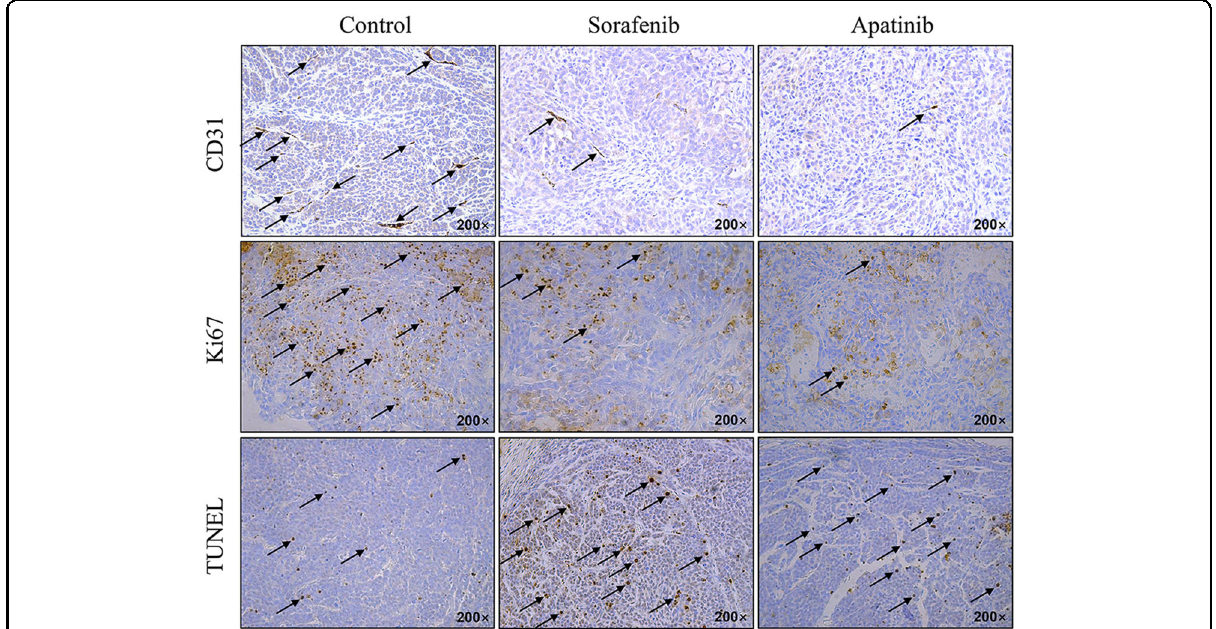
Fig. 5 Immunohistochemical analysis of CD31 and Ki67 expression and TUNEL analysis of apoptotic cells in the control and sorafenib and apatinib treatment groups on day 25 post-treatment